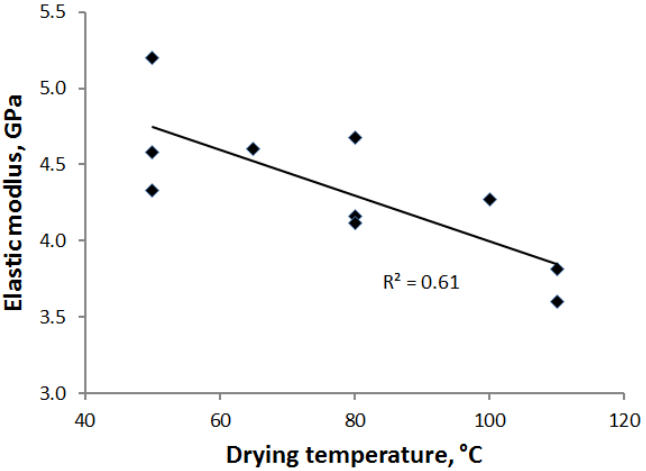
Figure 10. Elastic modulus of the calendered PCN sheets vs. drying temperature for all drying methods. For the combination of impingement and contact drying, the average temperature 65 °C (see Table 1) was used when plotting the